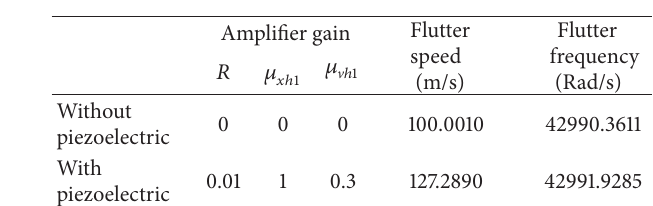
Figure 4: Root locus plot with piezoelectric actuator, 𝑅 = 0.01 , = 1 , 𝜇 = 0.3 . 𝜇 𝑥ℎ1 V ℎ1 Table 2: The effects of a certain piezoelectric actuator on flutter speed and